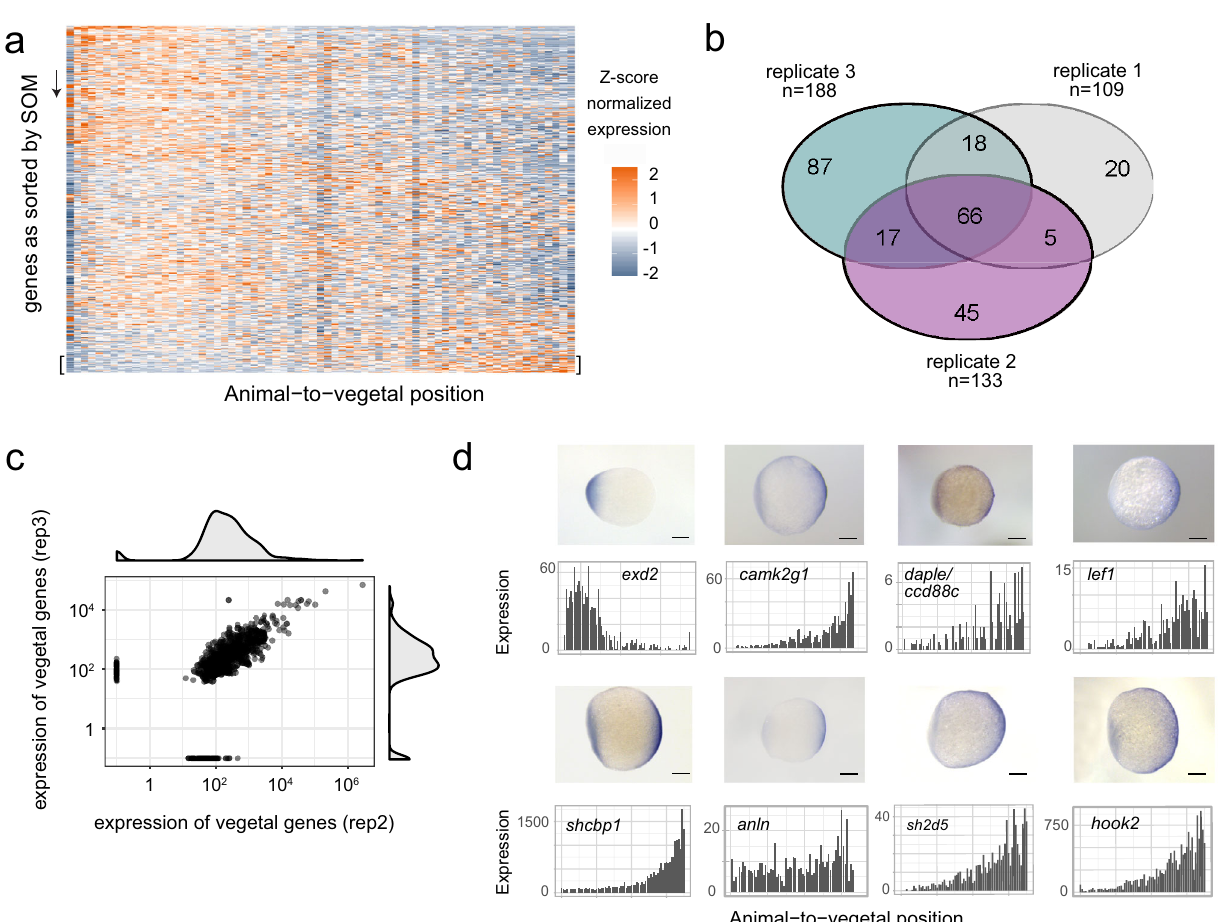
Fig. 2 Systematic identi fi cation of mRNA localization patterns. a Heatmap representation of z -score normalized expression per section in a zebra fi sh one-cell stage embryo. Genes on the y -axis as sorted into pro fi les 1 – 50 by SOM (self-organizing map), spatial position in the embryo on the x -axis. b Vegetally localized genes per sample (pro fi les 48 – 50). c Expression correlation of vegetally localized genes between two replicates. Genes on the axes are only detected in one sample. d Comparison of tomo-seq and whole-mount in situ hybridization for selected newly described vegetally localized genes, as well as the animally localized gene exd2 . Scale bars are 200 µ